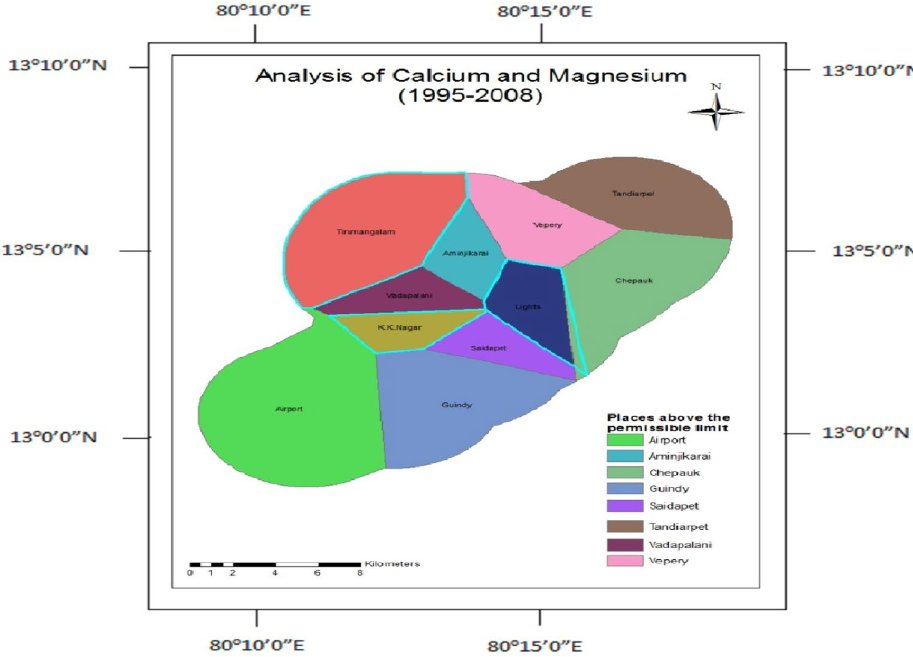
Figure 13. Analysis of calcium and magnesium for 1995-.